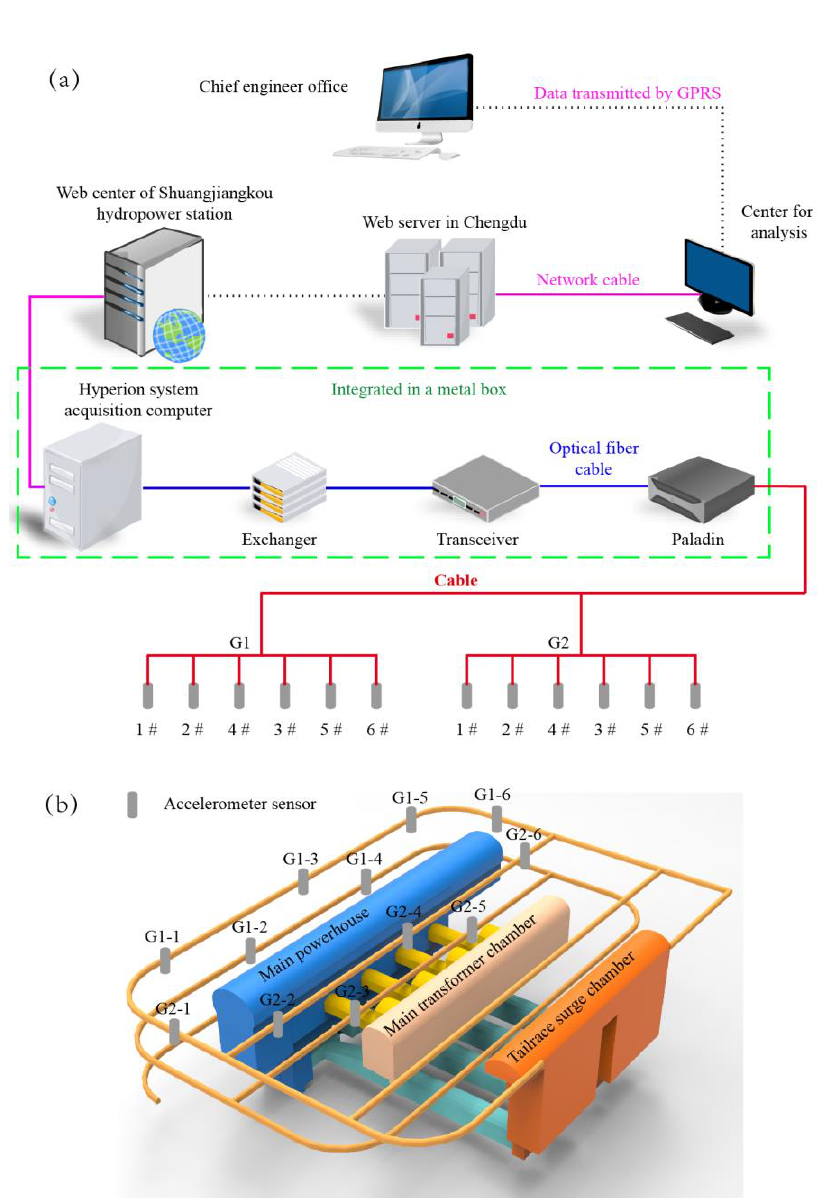
Figure 10. The layout of the MS monitoring system in the main powerhouse. ( a ) The MS monitoring system network topology. ( b ) The layout of the acceleration sensor.